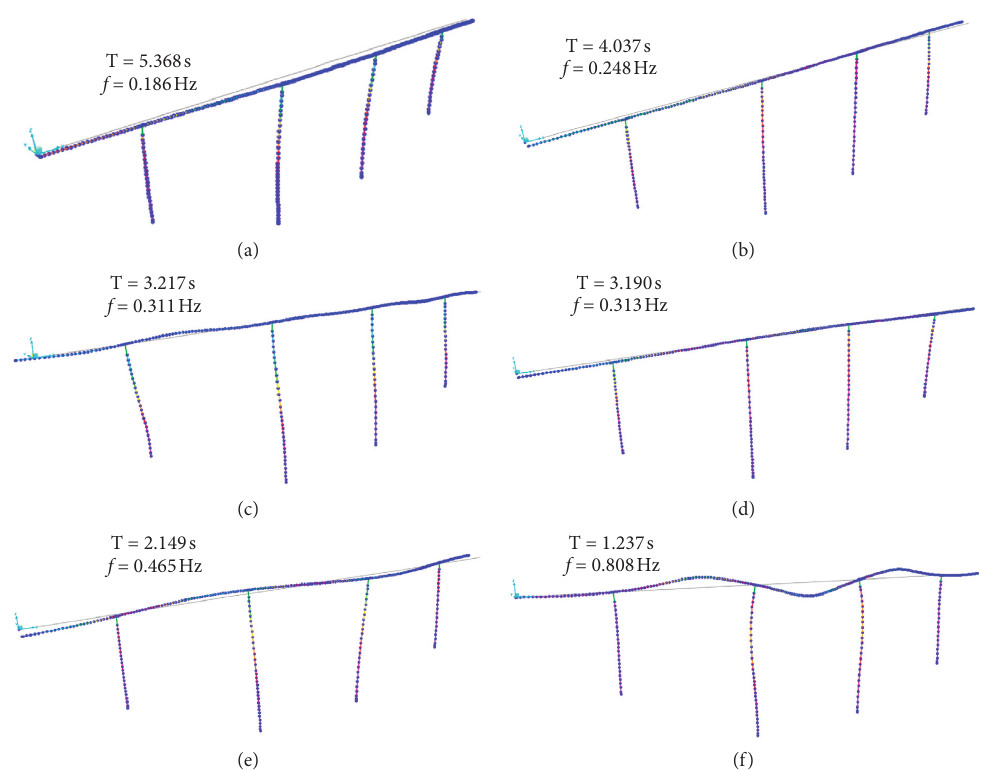
Figure 5: The dimensional model of Wolonggou Bridge in CSI-Bridge. (a) First-order vibration mode. (b) Second-order vibration mode. (c) Third-order vibration mode. (d) Fourth-order vibration mode. (e) Fifth-order vibration mode. (f) Sixth-order vibration mode.